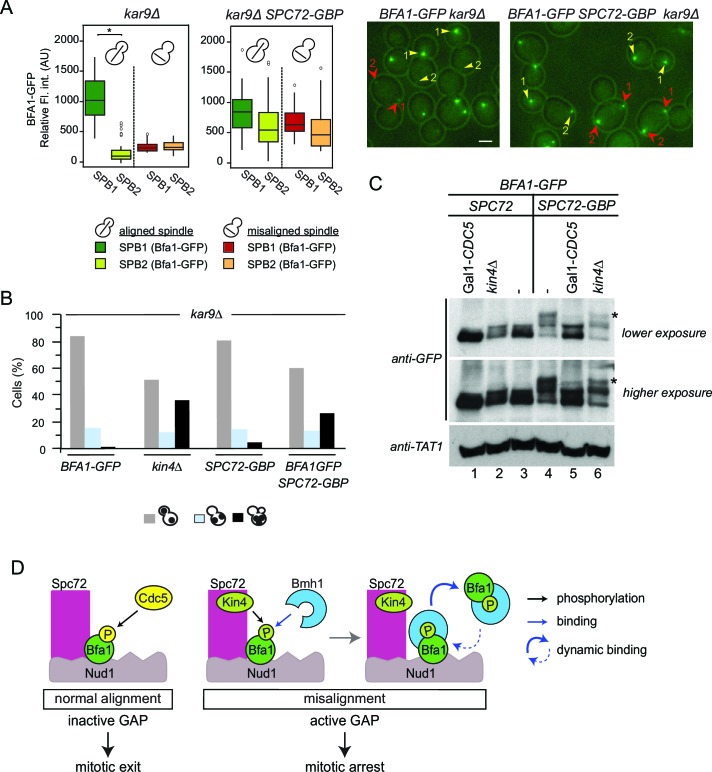
Bfa1-Spc72 interaction provokes Cdc5 phosphorylation of Bfa1 (A) Still images (right) and the SPB-bound mean fluorescence intensities (left) of Bfa1-GFP in kar9∆ and SPC72-GBP kar9∆ cells.SPB1 indicates the SPB closer to bud where SPB2 is the SPB closer to the mother cell compartment. Yellow or red arrows point the two SPBs in a cell with a normally aligned or misaligned spindle respectively. The numbers 1 and 2 next to the arrows indicate SPB1 and SPB2 respectively. Scale bar: 3 µm. In the Box-Whisker plots showing Bfa1-GFP mean fluorescence intensities, the boxes show the lower and upper quartiles, the whiskers show the minimum and maximal values excluding outliers; circles represent the outliers calculated as values greater or lower than 1.5 times the interquartile range; the line inside the box indicates the median. Asterisks show significant difference according to student’s t-test (p<0.001). Sample sizes for kar9∆ cells were 49 and 23, whereas sample sizes for kar9∆ SPC72-GBP cells were 38 and 14 for each SPB with normal and misaligned spindles respectively. See the accompanying data file for exact p-values (Figure 7—source data 1). (B) SPOC integrity of the indicated cell types. Cells were grown at 23°C and shifted to 30°C for 3 hr to induce the accumulation of cells with misaligned spindles (blue bars). Black bars show the percentage of multi-nucleated phenotypes, which indicates SPOC deficiency N: 100 cells per strain. A representative plot out of three biological replicates is shown. (C) Immunoblot showing Bfa1-GFP mobility shift. Indicated strains arrested in G1 using alpha-factor and released in alpha-factor free, nocodazole containing YPDA medium. Samples were collected after 2.5 hr. Gal1-CDC5 bearing strains were grown and G1-arrested in raffinose and galactose containing medium. Releasing from G1 block in glucose containing medium repressed the Gal1 promoter to maintain Cdc5 depletion. Bfa1-GFP was detected in the total cell extracts of the indicated strains using anti-GFP antibody. Anti-TAT1 antibody was used to detect tubulin as a loading control. Asterisks indicate the hyper-phosphorylated form of Bfa1. A representative blot out of three independent experiments is shown. (D) Model for SPOC activation and Bfa1-SPB remodeling. When the mitotic spindle is correctly aligned, Bfa1 molecules are stably in contact with Nud1 and Spc72, where Cdc5 can phosphorylate and thereby inactivate Bfa1. When the spindle misaligns, Kin4 binds to Spc72 to phosphorylate Bfa1 (Maekawa et al., 2007). Kin4 phosphorylated Bfa1 is recognized by Bmh1 (Caydasi et al., 2014). Bmh1-bound Bfa1 disconnects from Spc72 but remains associated with Nud1, although dynamically. Cdc5 cannot phosphorylate Bfa1 when Bfa1 is disconnected from Spc72.DOI:
http://dx.doi.org/10.7554/eLife.14029.03710.7554/eLife.14029.038Figure 7—source data 1.Raw and normalized mean fluorescence intensities of Bfa1-GFP at SPBs of SPC72 kar9∆ and SPC72-GBP kar9∆ cells with normally aligned or misaligned spindles (source data for Figure 7A).